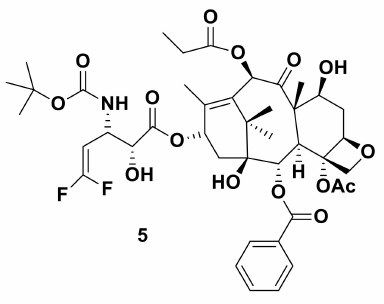
Figure 3. 3 (cid:48)